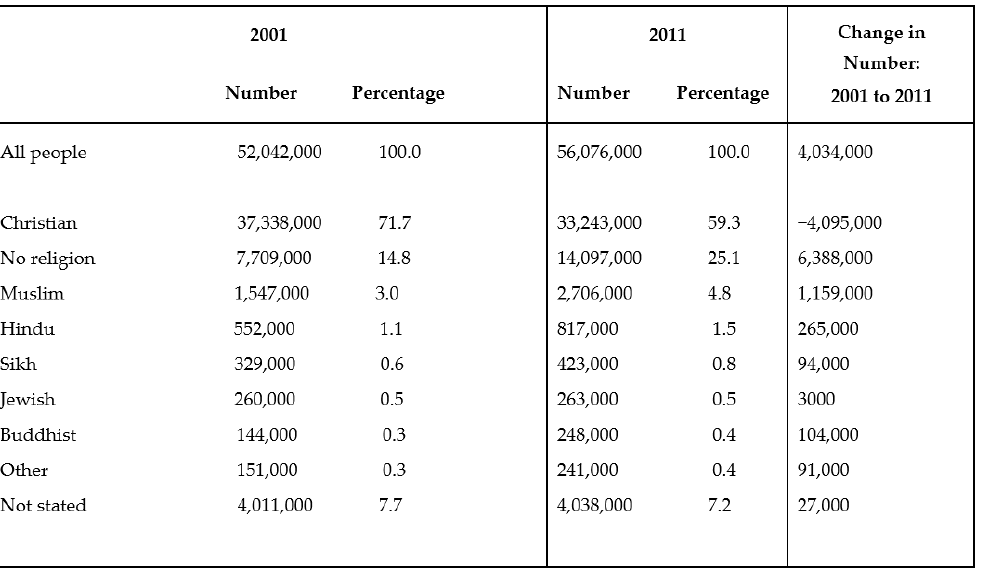
Figure 1. Religion in England and Wales 2001 and 2011 (Office for National Statistics).